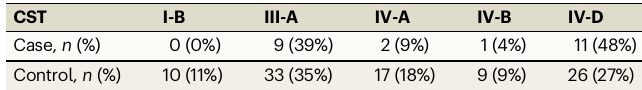
Table 2 | Counts and percentages of cases and controls by vaginal community state